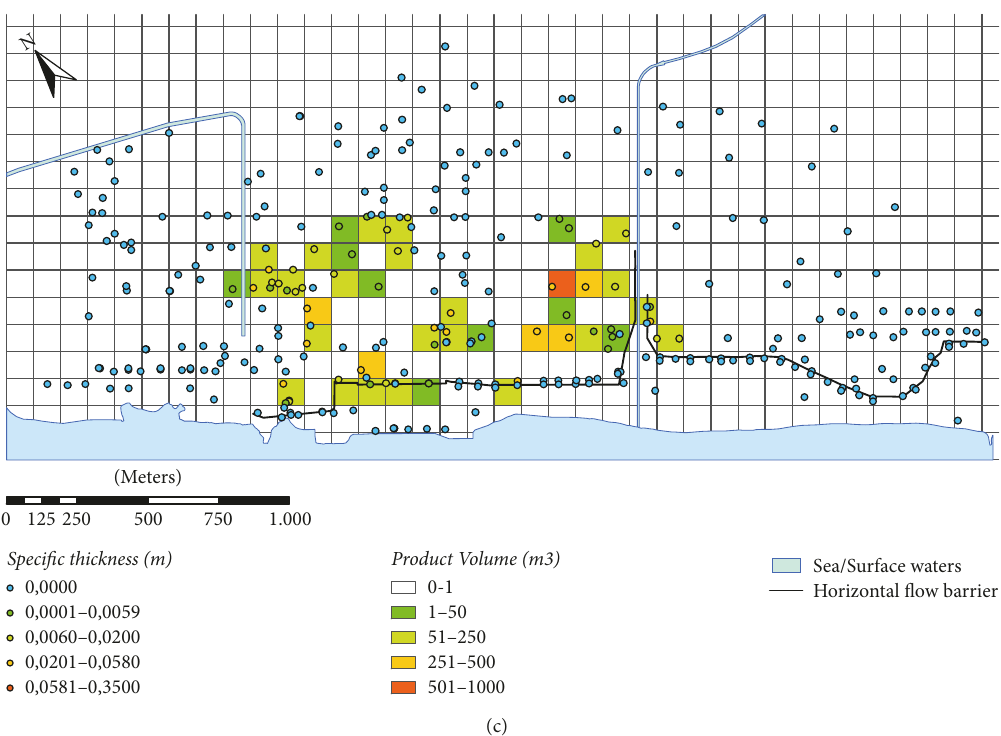
Figure 5: Product volume distribution in the study site at June 2013. The product volume was calculated using Pancake Model and Thiessen polygons (a), grid at regular square mesh (200 × 200) (b), and grid at regular square mesh (100 × 100)